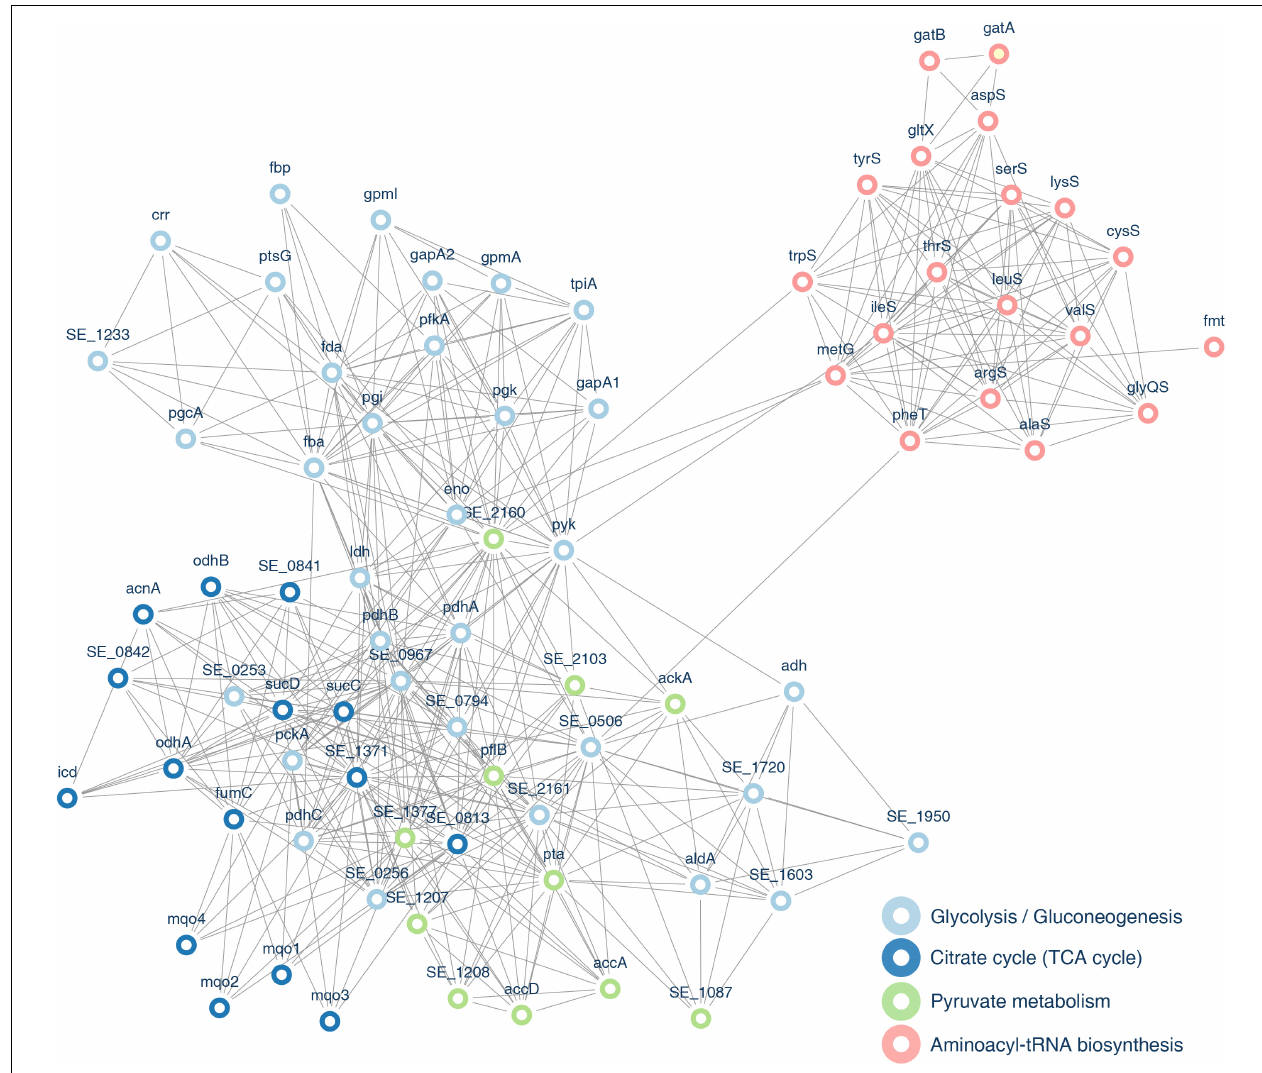
FIGURE 13 | Protein–protein interaction (PPI) network of identified proteins associated with pyruvate metabolism, glycolysis/gluconeogenesis, TCA cycle, and aminoacyl-tRNA biosynthesis